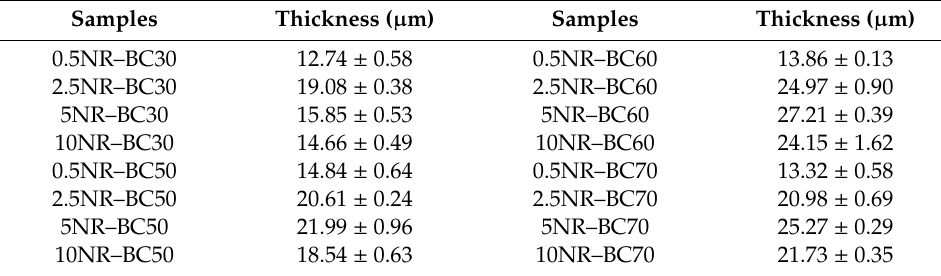
Table 1. Thickness of natural rubber (NR)–bacterial cellulose (BC)